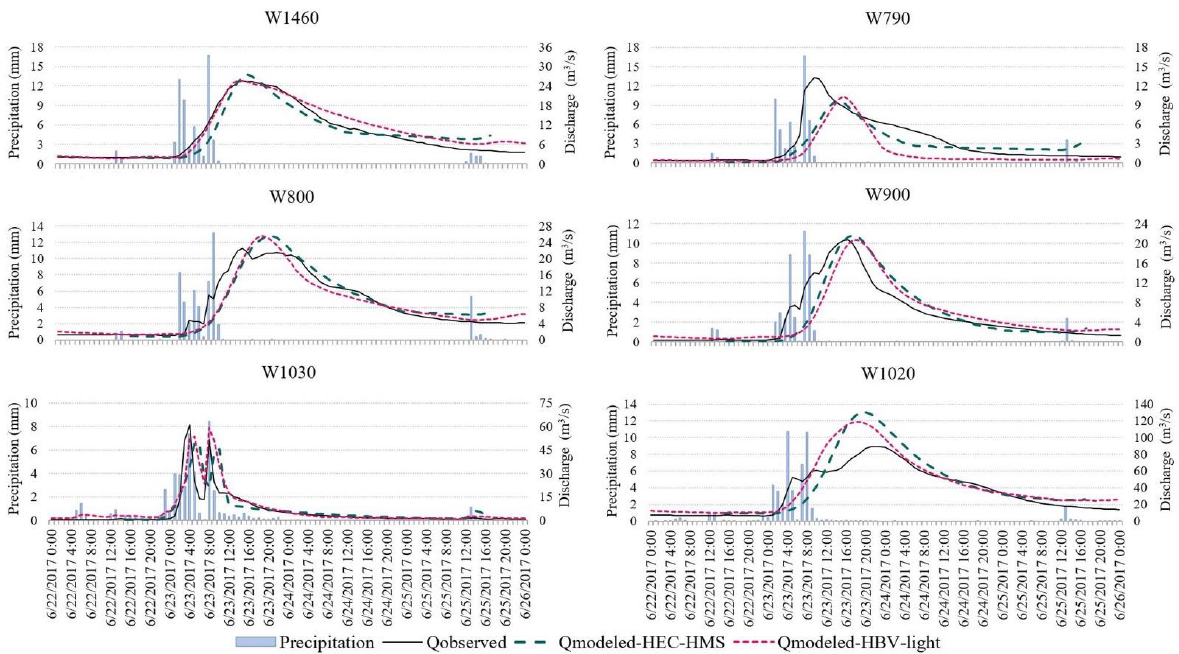
Figure 7. Precipitation, observed and modeled discharge of the 26 – 30 June 2010 rain event at the six gauged stations.